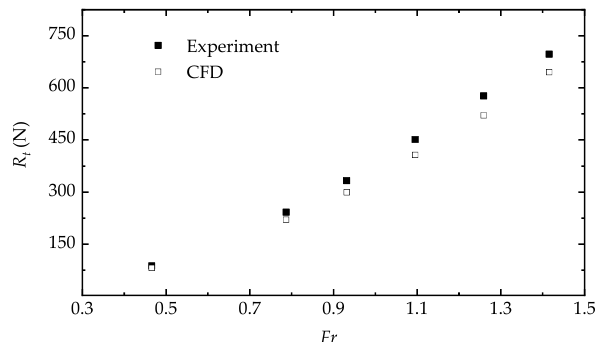
Figure 4. Validation of the resistance results.